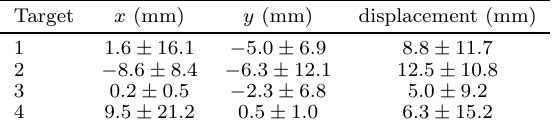
Table 2: Mean and standard deviation of average pulse rate error for various